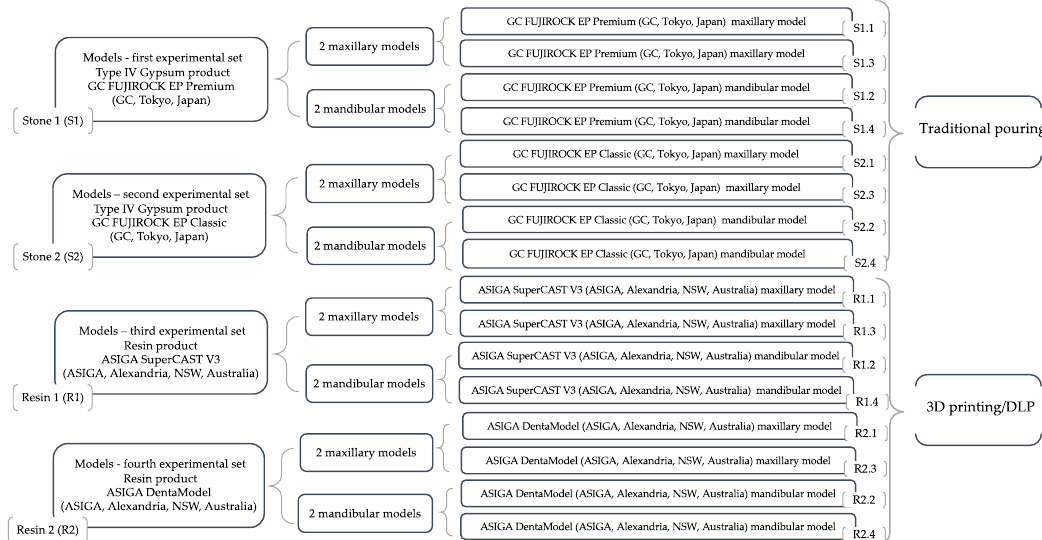
Figure 2. Experimental case study models. Dental Stone Models